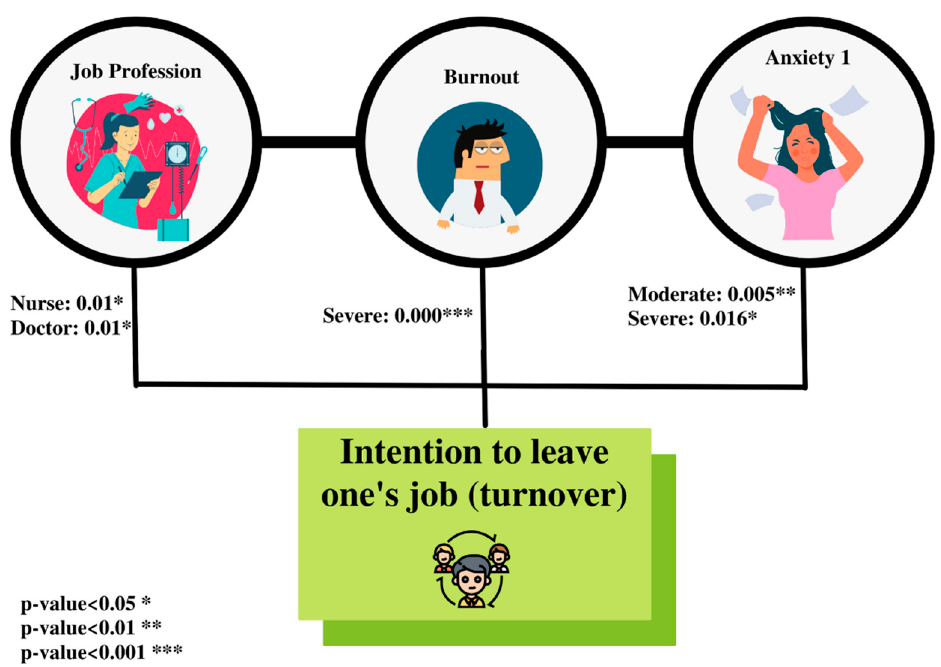
Figure 2. Predictors of turnover intention.